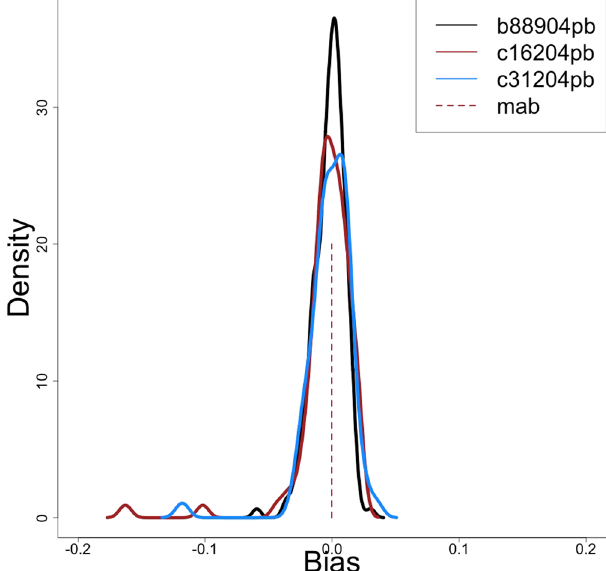
Figure 3. Drift rate evaluation. Density plot shows the bias calculation for the final drift rates obtained using summarized profiles relative to the “true” drift rates obtained from high-resolution data. Curves are shown for the three processed seals (n = 735, 191 and 200 drift dive observations), together with the median averaged bias (mab = −